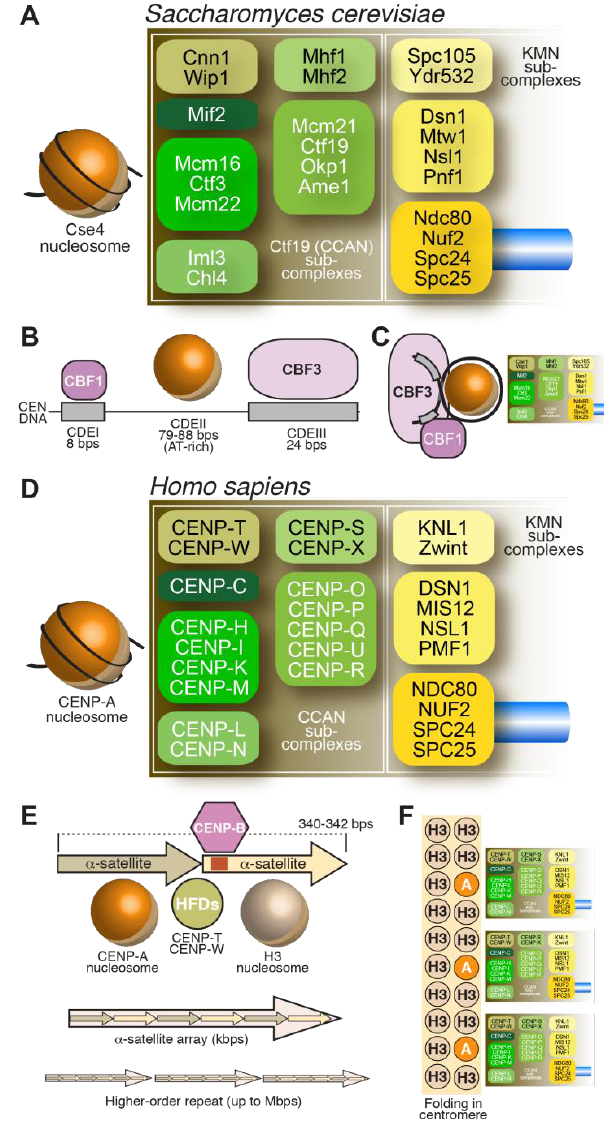
Figure 2. Schematic summary of the structural organization of budding yeast and human kinetochores. Related colors highlight conserved components/complexes. ( A ) Schematic of the S. cerevisiae